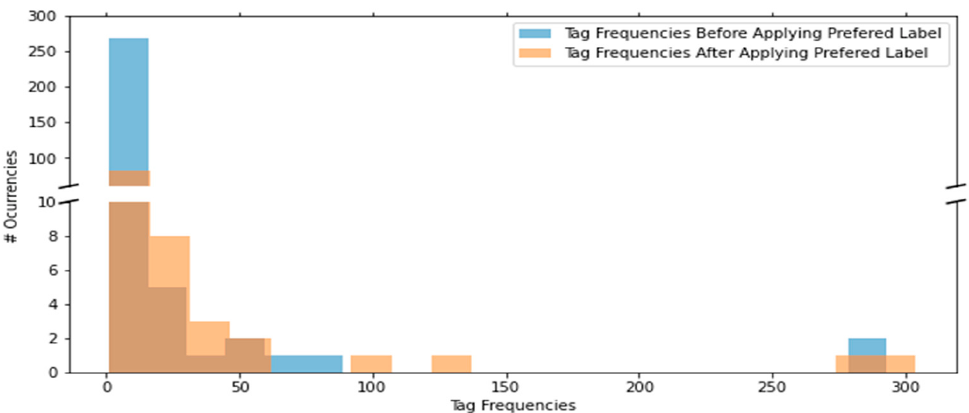
Figure 6. Frequency distributions of raw data tags before tag unification vs. unified tags after applying preferred labels. Table 6. Two examples of raw data rows and their corresponding structured output.